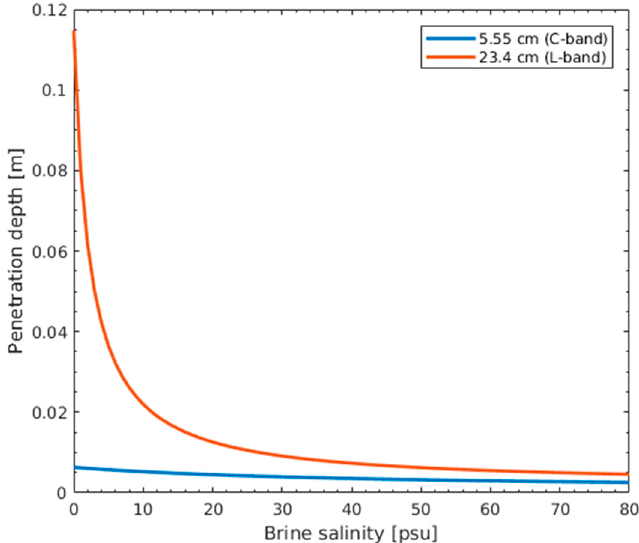
Figure 7. C- and L-band penetration depth δ p through a saturated saline soil of varying brine salinity. The dielectric constant is computed by means of a simple dielectric mixing model.